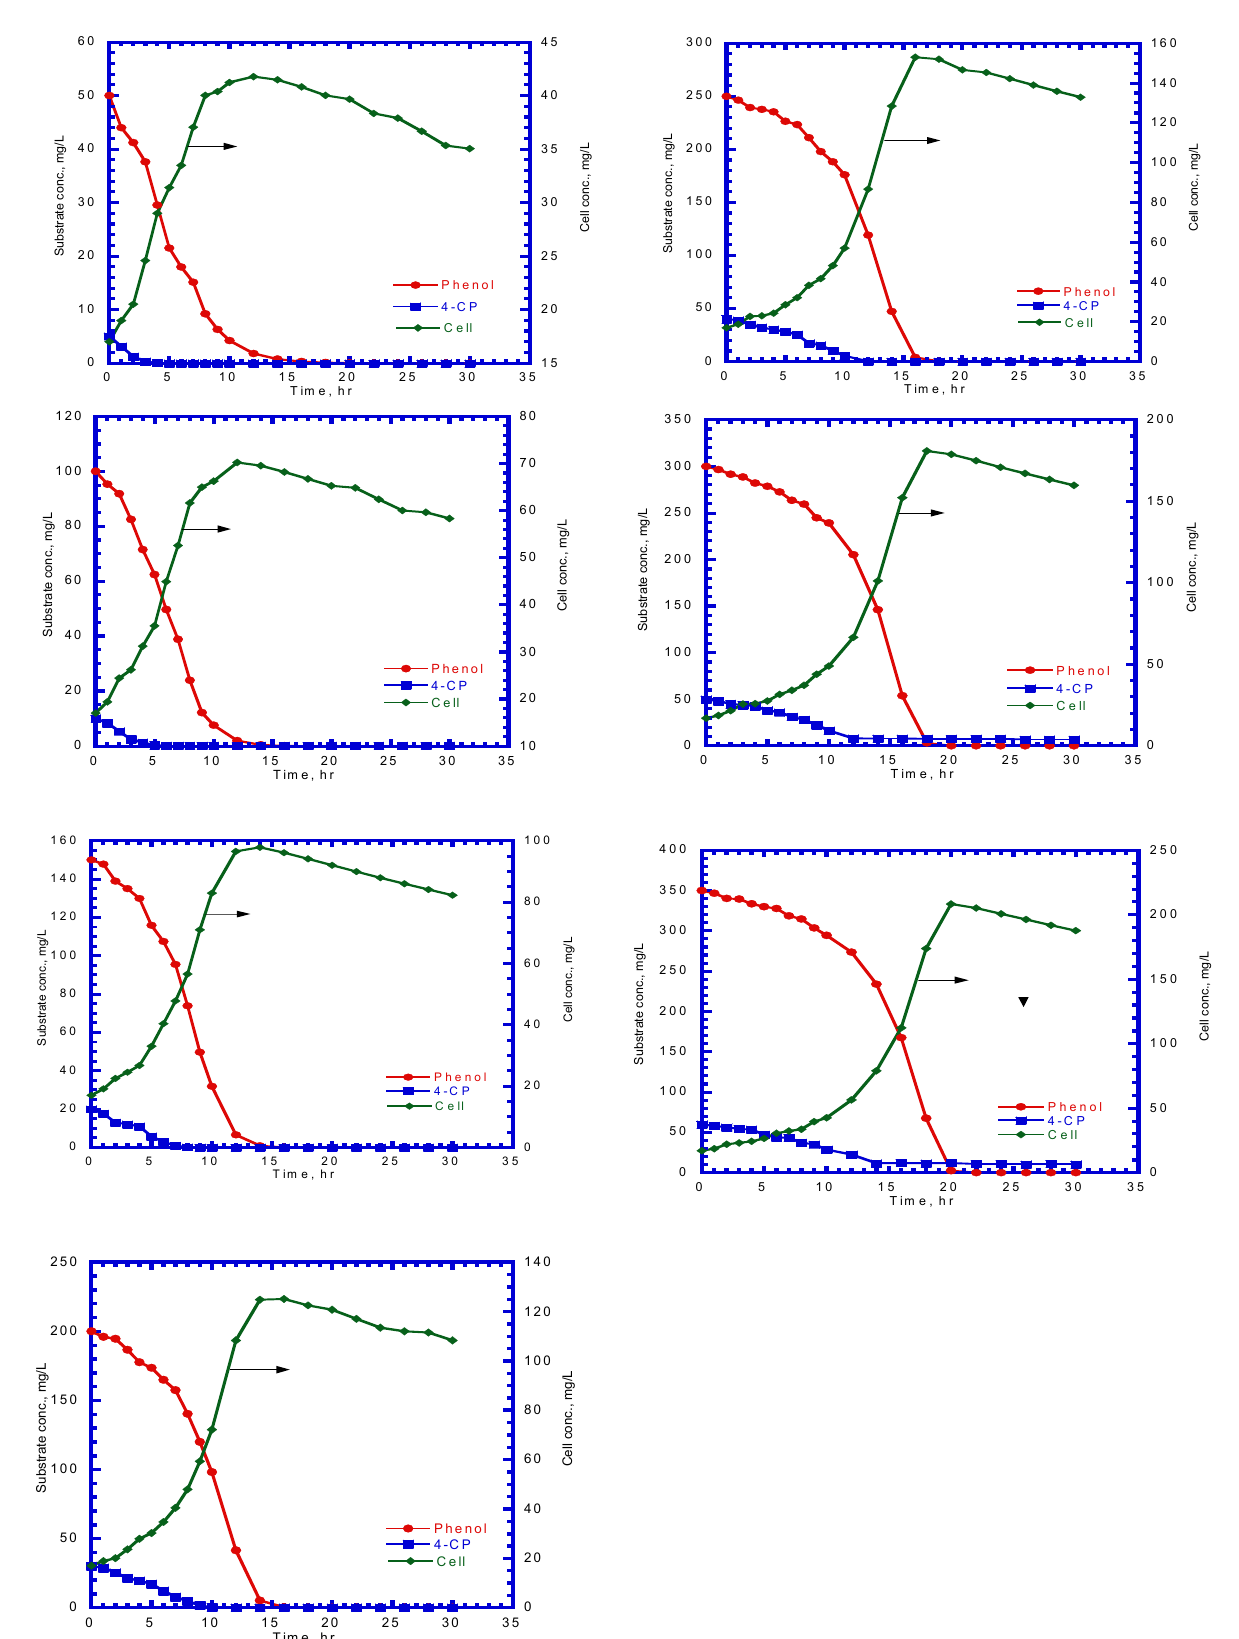
Figure 8. Phenol degradation and 4-CP transformation and cell growth at various initial nominal phenol and 4-CP concentrations of 50–350 mg phenol/L and 5–60 mg 4-CP/L, respectively. Initial cell concentration = 17 mg/L.